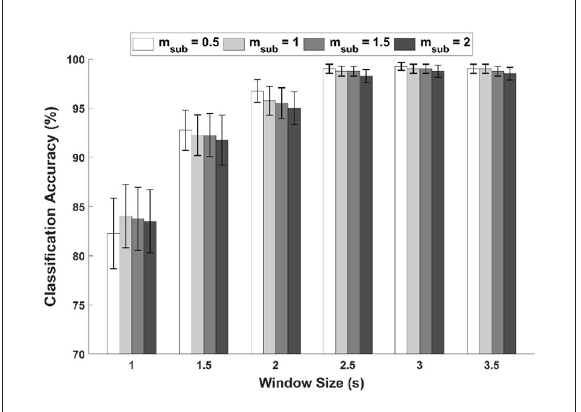
FIGURE13 Average classification accuracies for PRS-Square as a function of m sub in sFBCCA with different window